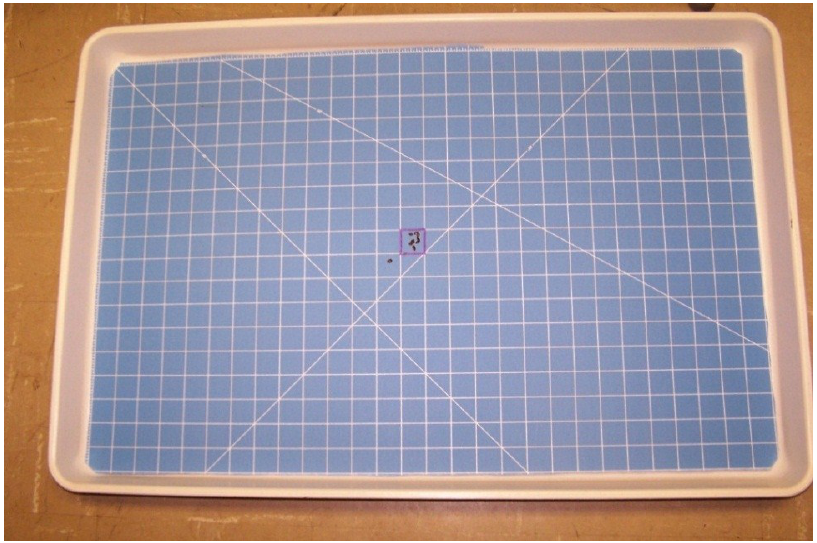
Figure 2. Two-dimensional arena set-up showing bed bug positions almost immediately after